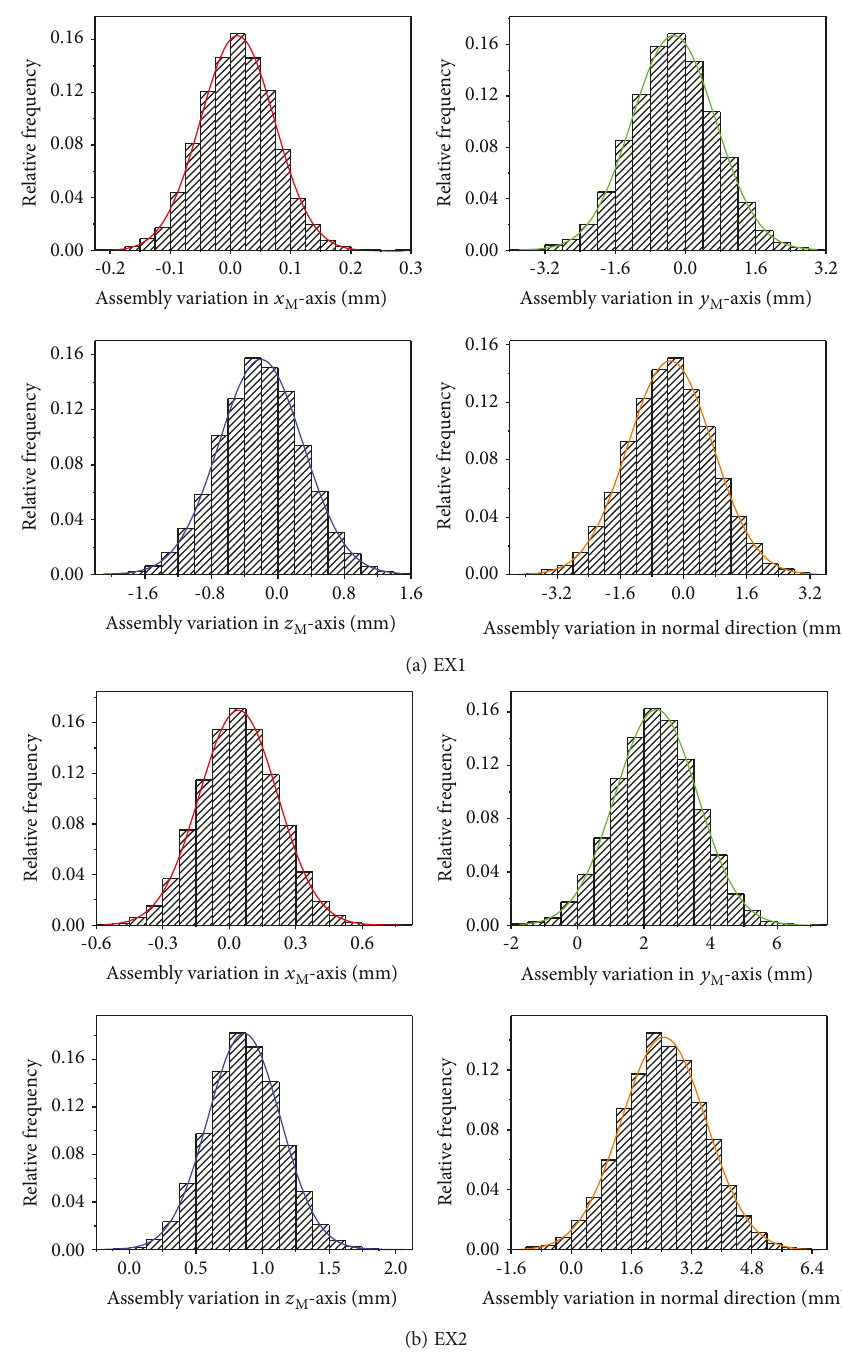
Figure 9: Distributions of assembly variations at K